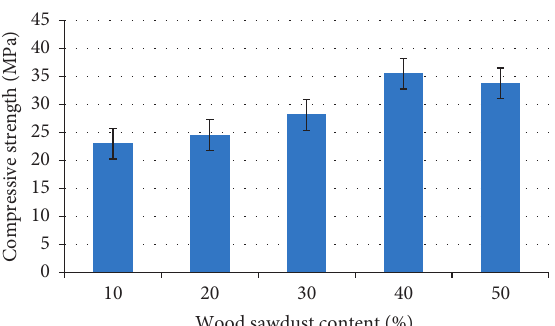
Figure 6: Effect of sawdust content on compressive strength.